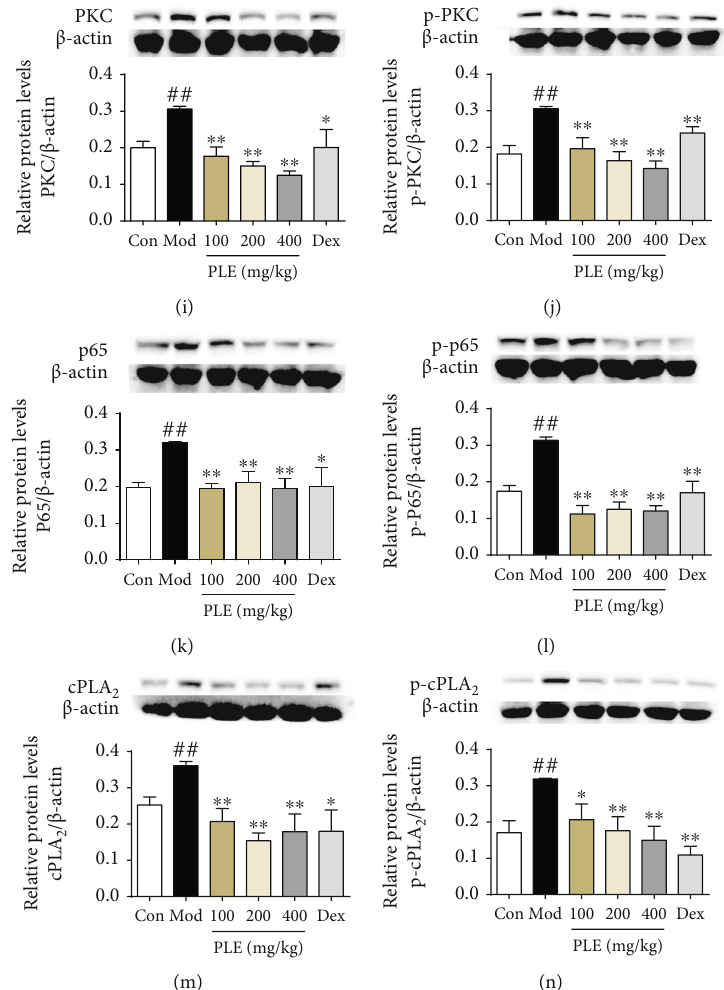
Figure 3: E ff ects of PLE on the expressions and phosphorylation of Syk and its downstream signaling molecules in vivo . (a) The representative photomicrographs ( × 200), (b) percentage of positively stained cells, and (c) mean integrated optical density (MOD) of Syk staining ( n = 15 independent slices from three mice in each group). (d) Representative photomicrographs ( × 200), (e) percentage of positively stained cells, and (f) MOD of p-Syk staining ( n = 15 independent slices from three mice in each group). The expression of (g) Syk, (h) p-Syk, (i) PKC, (j) p-PKC, (k) p65, (l) p-p65, (m) cPLA , and (n) p-cPLA in OVA-induced asthma mouse lung tissues was 2 2 determined by WB ( n = 5 ). ## P < 0 : 01 vs. the control group; ∗ P < 0 : 05 and ∗∗ P < 0 : 01 vs. the model